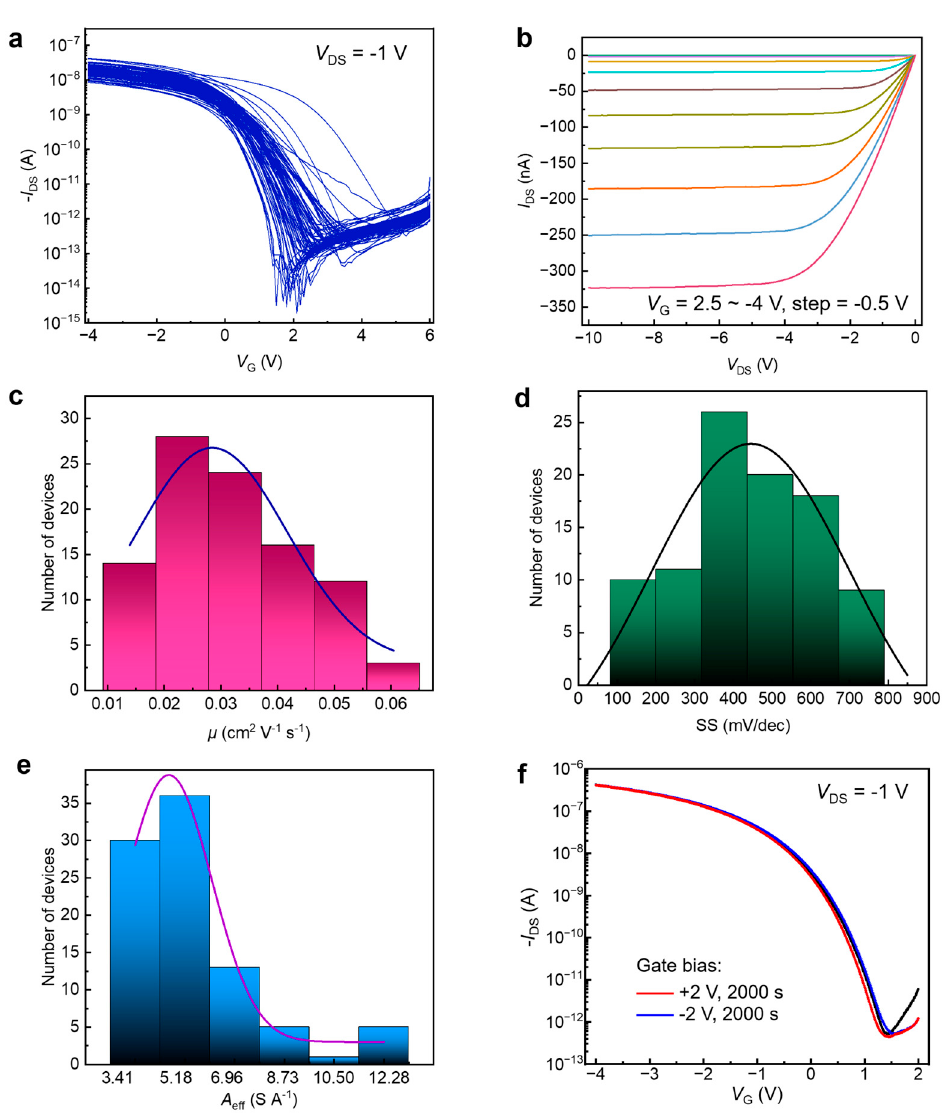
Figure 2. Electrical performance of the fully-printed OPT array in the dark. ( a ) Transfer characteristics of 90 OPTs in the 10 × 10 device array. ( b ) Output curves of a representative OPT in the dark. ( c – e ) Distribution of mobility, subthreshold swing, and signal amplification efficiency measured over 90 OPTs. ( f ) Transfer characteristics of a typical OPT measured at gate bias